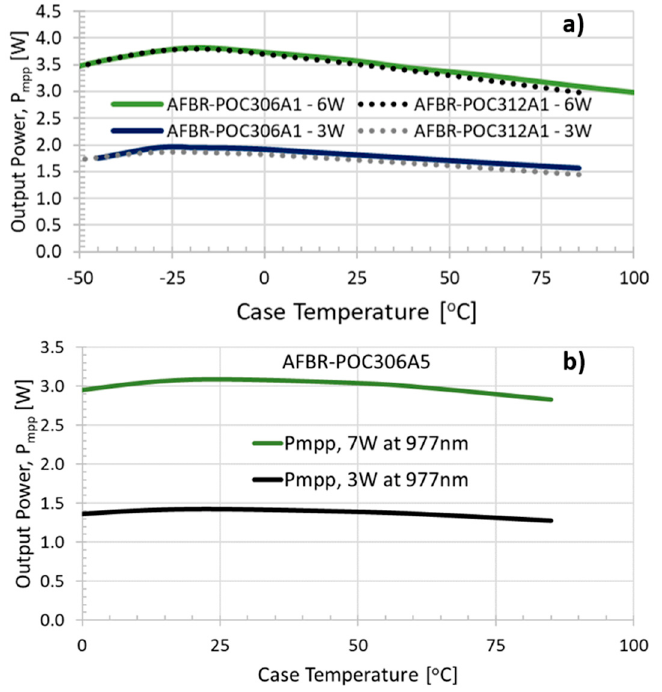
Figure 5. Temperature dependence of the output power for the medium-power OPCs for spectral range option of 800–830 nm in ( a ), and for 960–990 nm in ( b ). Test details are indicated on the plot. The average optical intensities are 20.8, 41.6, and 48.5 W/cm 2 for the P in of 3 W, 6 W, and 7 W respec ‐ tively.